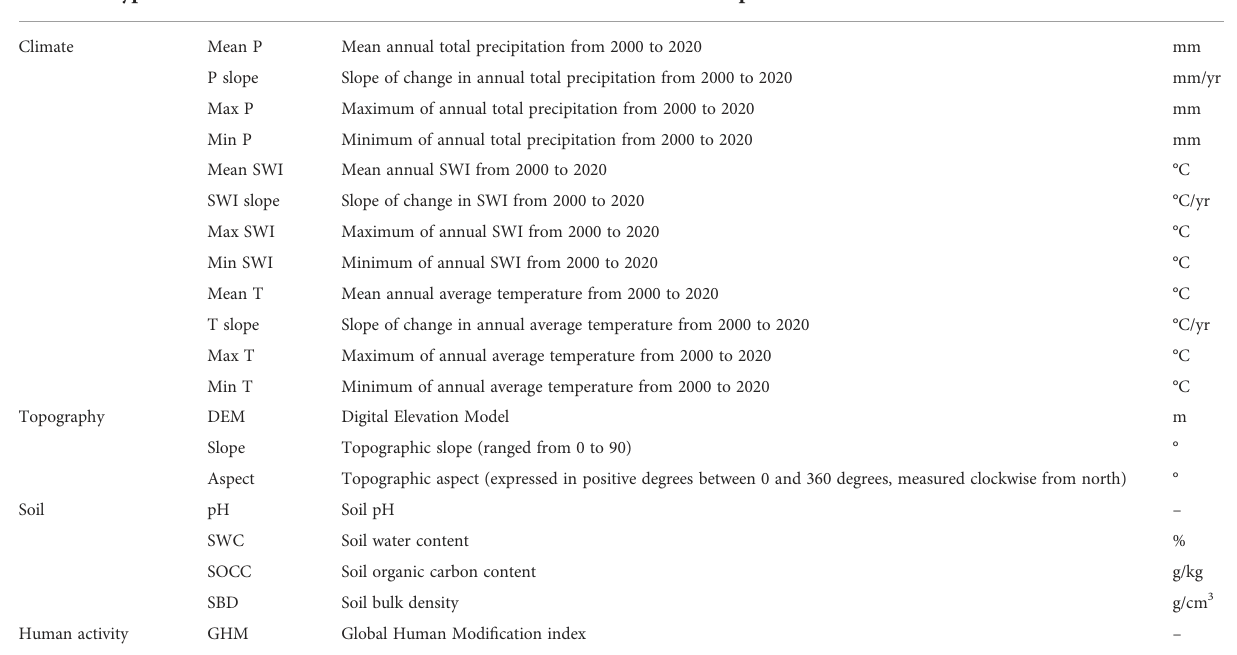
TABLE 2 Potential drivers of vegetation greenness browning and